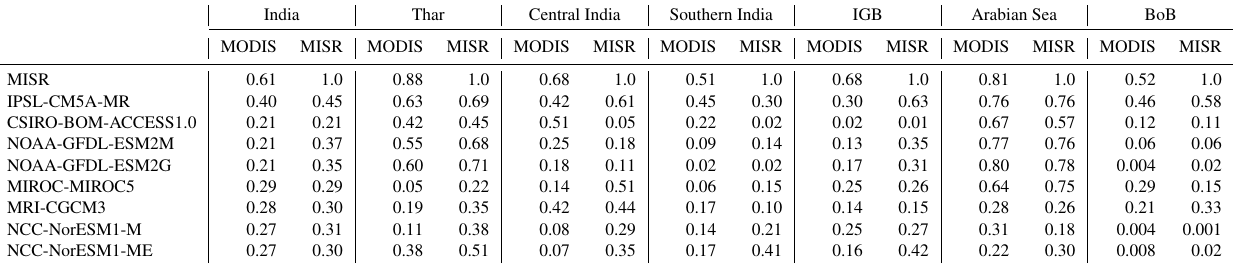
Table 3. Summary of correlation results over the sub-regions depicted in Fig. 6. India Thar Central India Southern